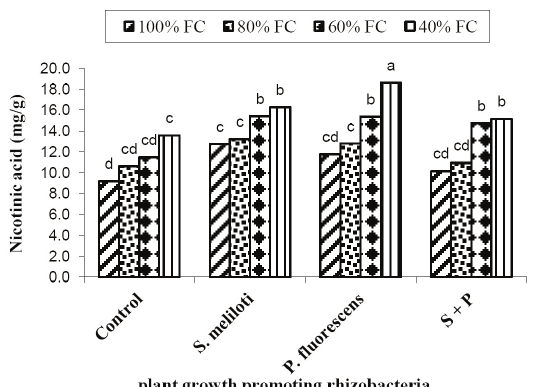
fig. 10 -Interaction of PGPR and soil water content on nicotinic acid of fenugreek